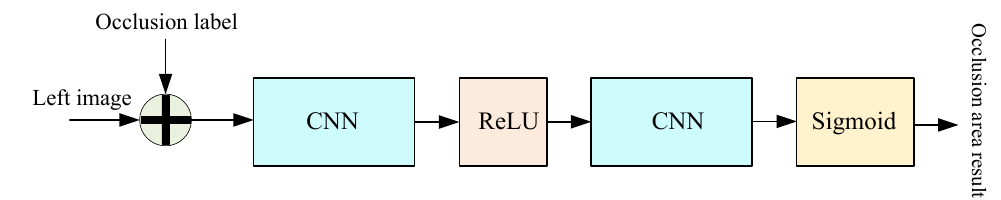
Figure 9. Occlusion area